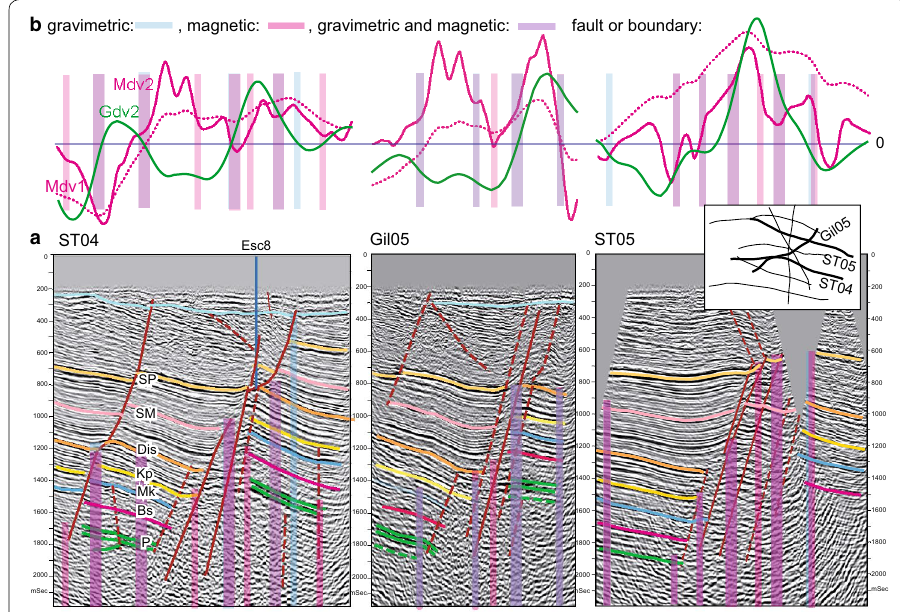
Fig. 10 a Migrated seismic sections. Inset: location of the profiles (see also Fig. 1a). Reflectors: SP schistes à poissons; SM schistes à Melettes; Dis Jurassic/Eocene discordance; Kp-top of the Triassic; Mk top of the Muschelkalk; Bs top of the Buntsandstein; P top of the Palaeozoic basement. Faults are in red. b The vertical (Mdv1) and second vertical (Mdv2) derivatives of the magnetic anomaly reduced to the pole indicate faults and discontinuities within the basement. The second vertical derivative of the Bouguer (Gdv2) anomalies locates the faults and discontinuities of both the sedimentary cover and the crystalline basement. The 0 level of the second vertical derivatives shows faults and boundaries provided these are subvertical. The discontinuities are in red (Mdv1 and Mdv2), blue (Gdv2) or violet when both magnetic and gravimetric gradients